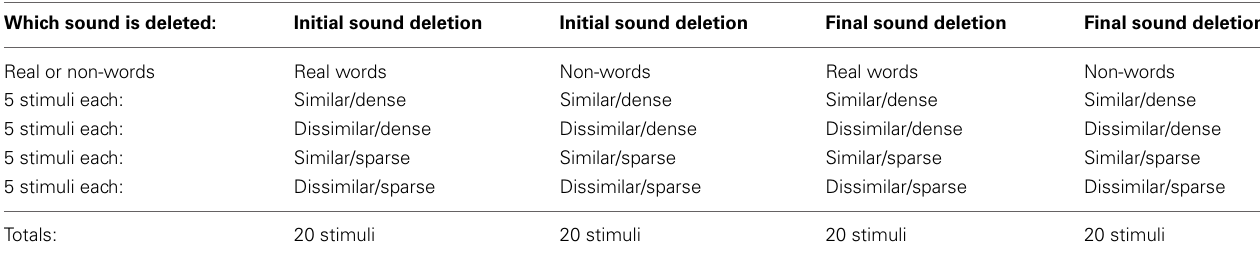
Table 3 | All possible combinations of stimuli during the